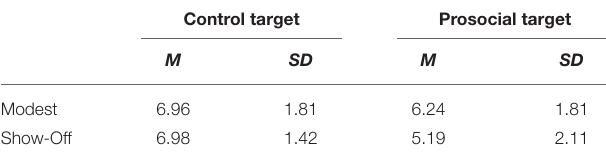
TABLE 4 | Mean target likeability ratings per condition in Experiment